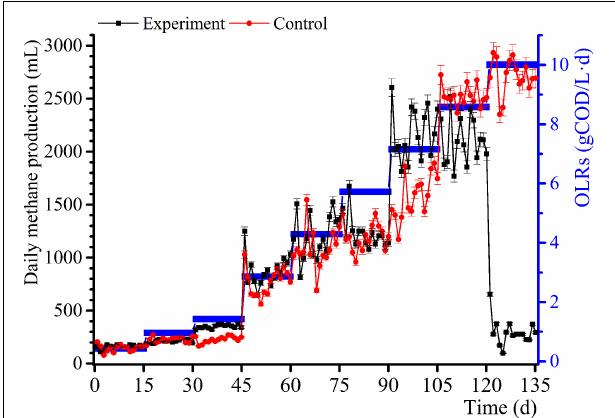
FIGURE 1 | Variation in daily methane production with increasing